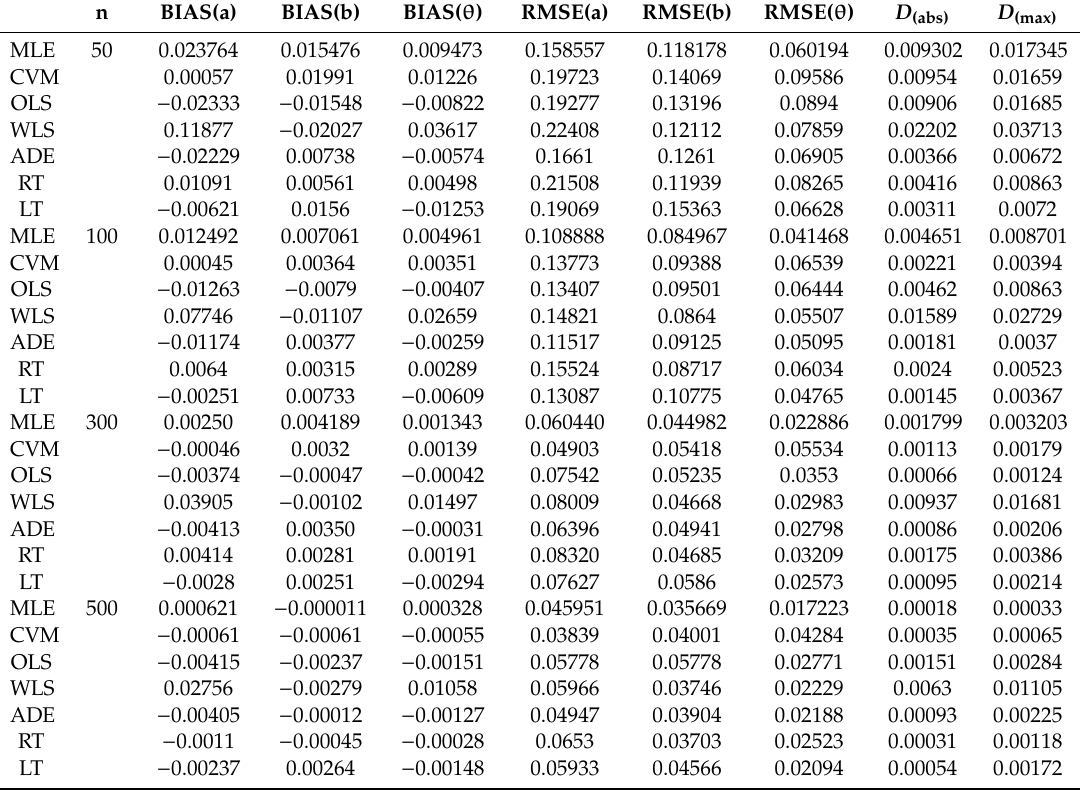
Table 4. Simulation results for parameters a = 1.25, b = 0.8, and θ =